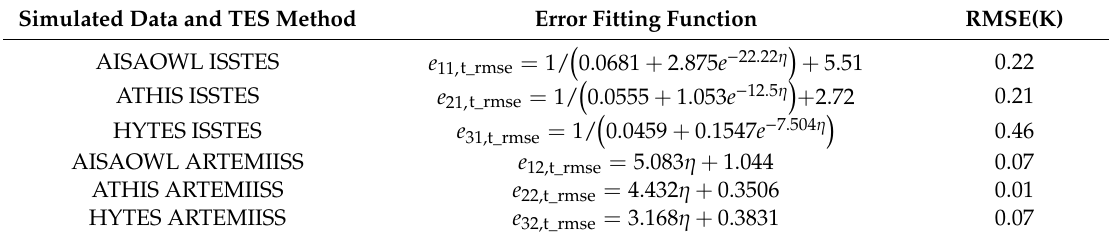
Table 11. The LST error fitting function about NEDT when center wavelength shift ratio = 0.05 and FWHM change ratio =